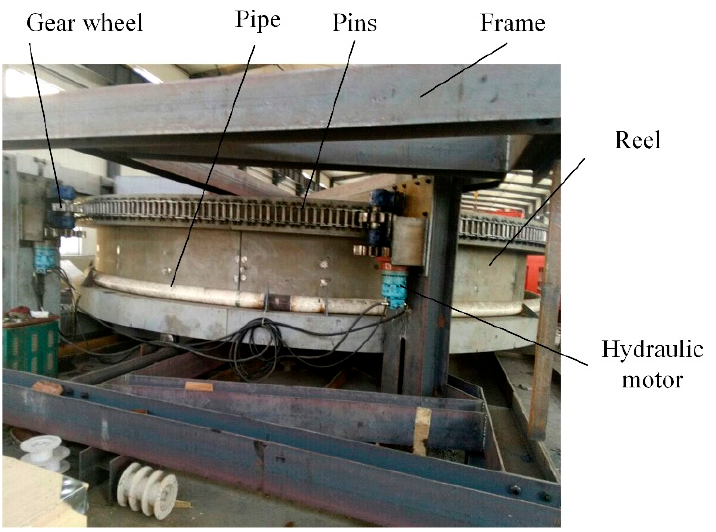
Figure 3. Pipe-reeling experiment equipment.